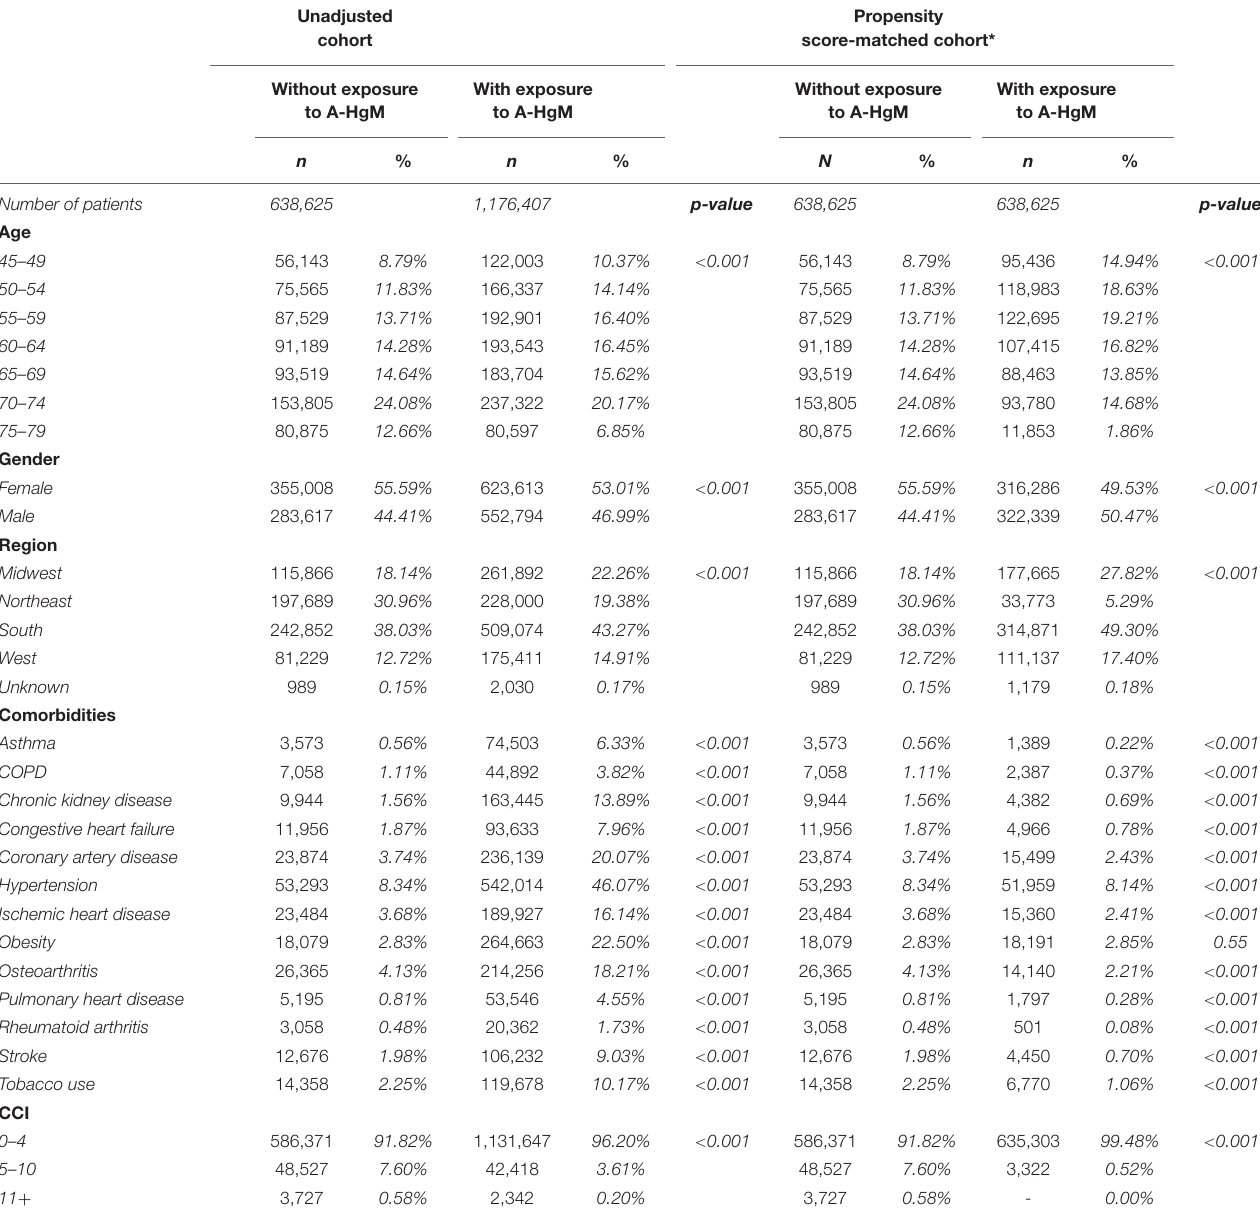
TABLE 4 | Baseline characteristics for unadjusted and propensity score-matched patients with or without exposure to anti-hyperglycemic medication.